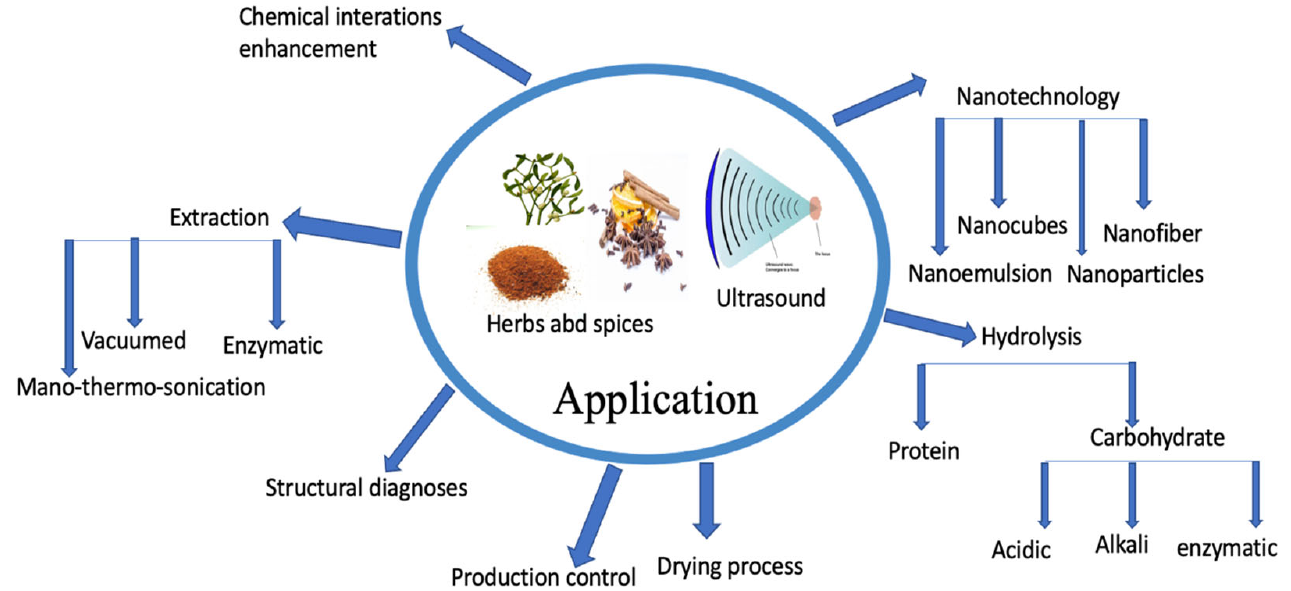
Figure 3. Exploring the fundamental applications linking ultrasonic technology and herbal science.